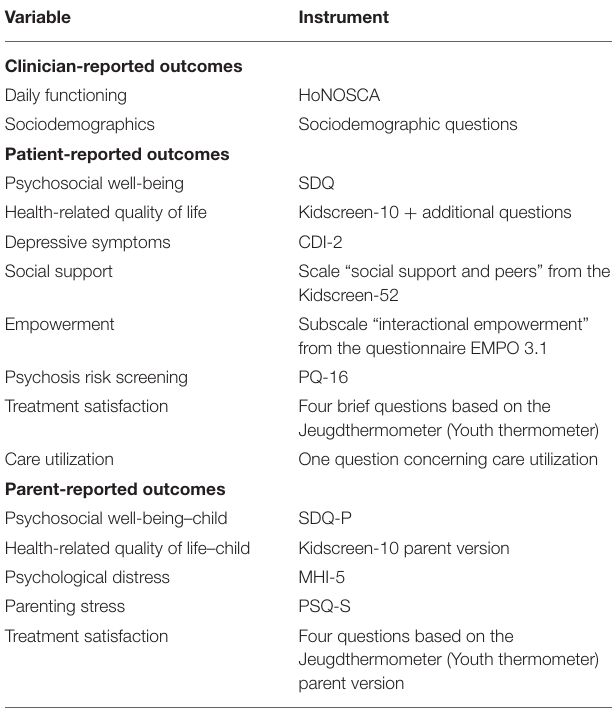
TABLE 1 | Overview of outcome assessments at